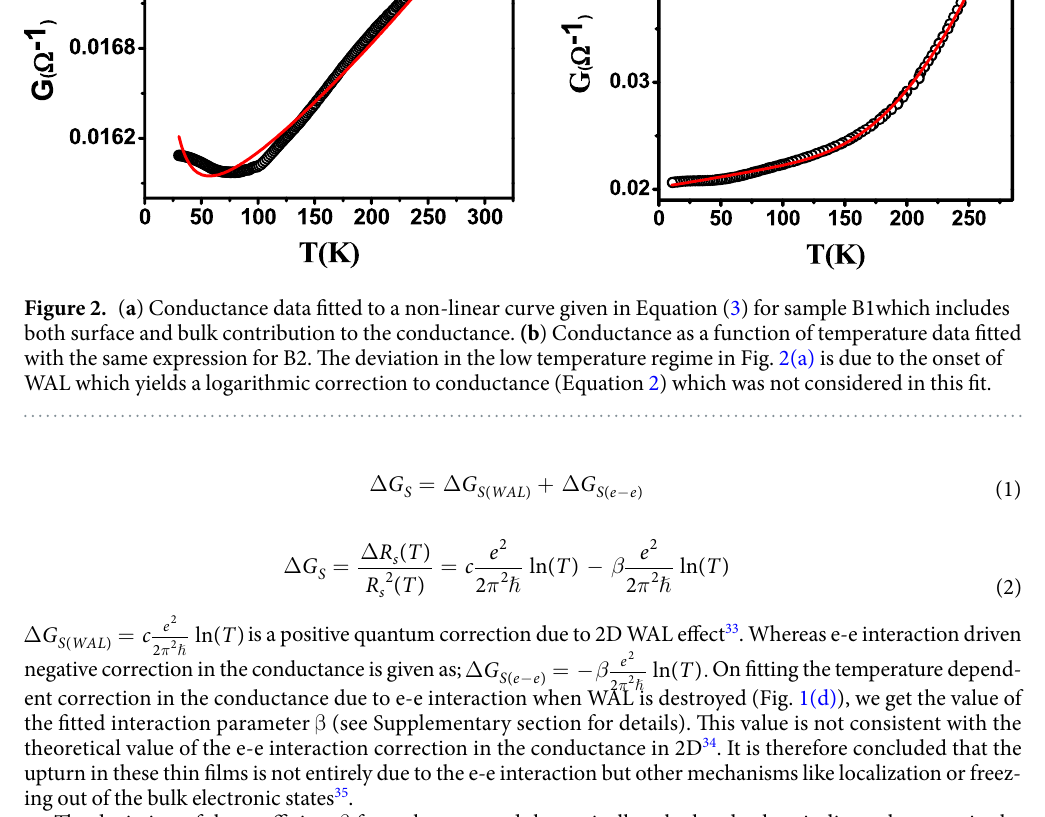
theoretical value of the e-e interaction correction in the conductance in 2D 34 . It is therefore concluded that the upturn in these thin films is not entirely due to the e-e interaction but other mechanisms like localization or freez- ing out of the bulk electronic states 35 . The deviation of the coefficient β from the expected theoretically calculated values indicate that even in the low temperature regime in the two insulating thin films (B1 and B2) do not show fully 2D transport and the total conduction is a combination of conduction of bulk and surface connected in parallel, henceforth referred to as the parallel channel conduction mechanism. The value of the parameter β could be used to estimate the truly 2D character of surface states of the bulk insulating TIs. Earlier electron-electron interactions have been observed in doped metallic thin films and ultrathin metallic films 33, 36 . In these cases it could not be conclusively inferred whether the interaction is among surface states or the bulk states. Parallel channel conductance model has been used to fit the conductance vs T plot as shown in Fig. 2. The two parallel channels being bulk conductance ( G b ) and surface conductance ( G S ). The combination of bulk and surface conductance, the total conductance; G t is represented by: